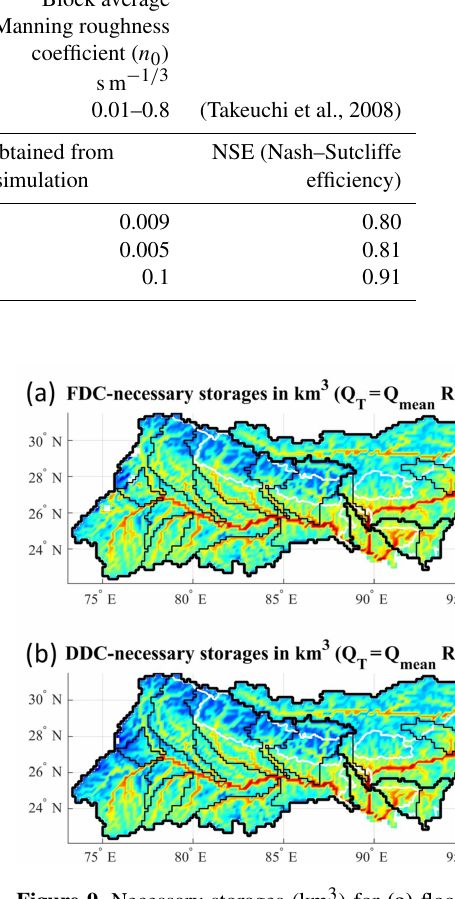
Figure 9. Necessary storages (km 3 ) for (a) flood and (b) drought management with target discharge Q T = Q mean of return period 5 years. The simulated discharge was for